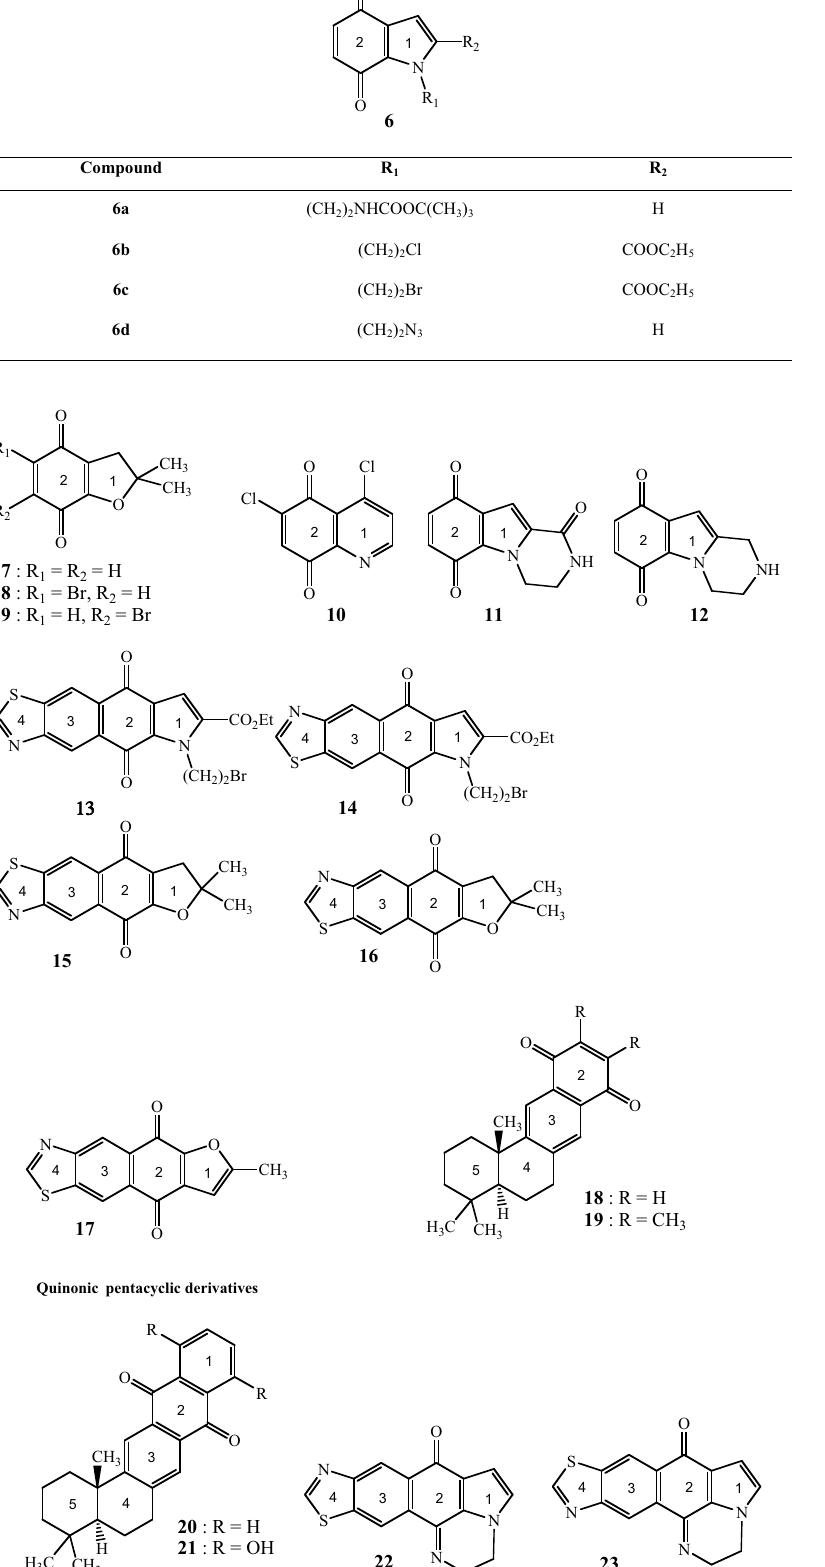
Fig. 2. – Structure of quinonic bi- or polycyclic derivatives